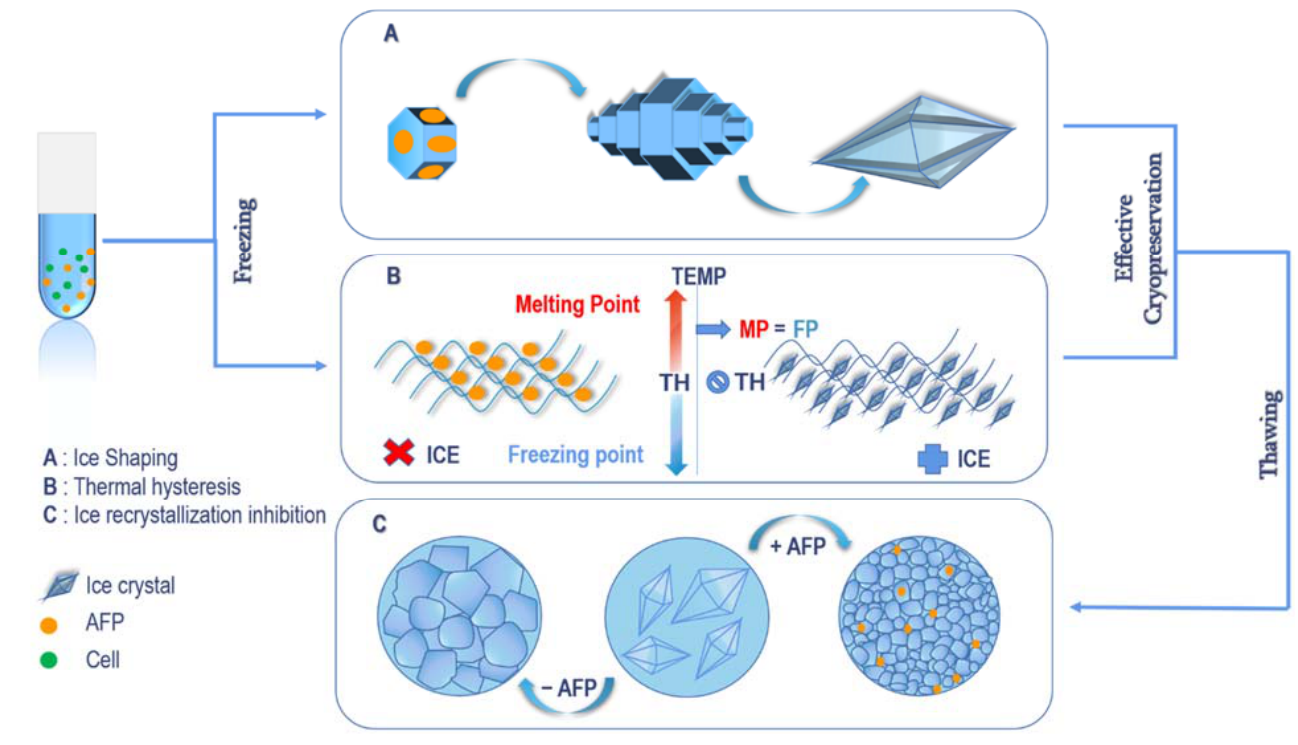
Figure 2. Mechanism of action of AFPs .